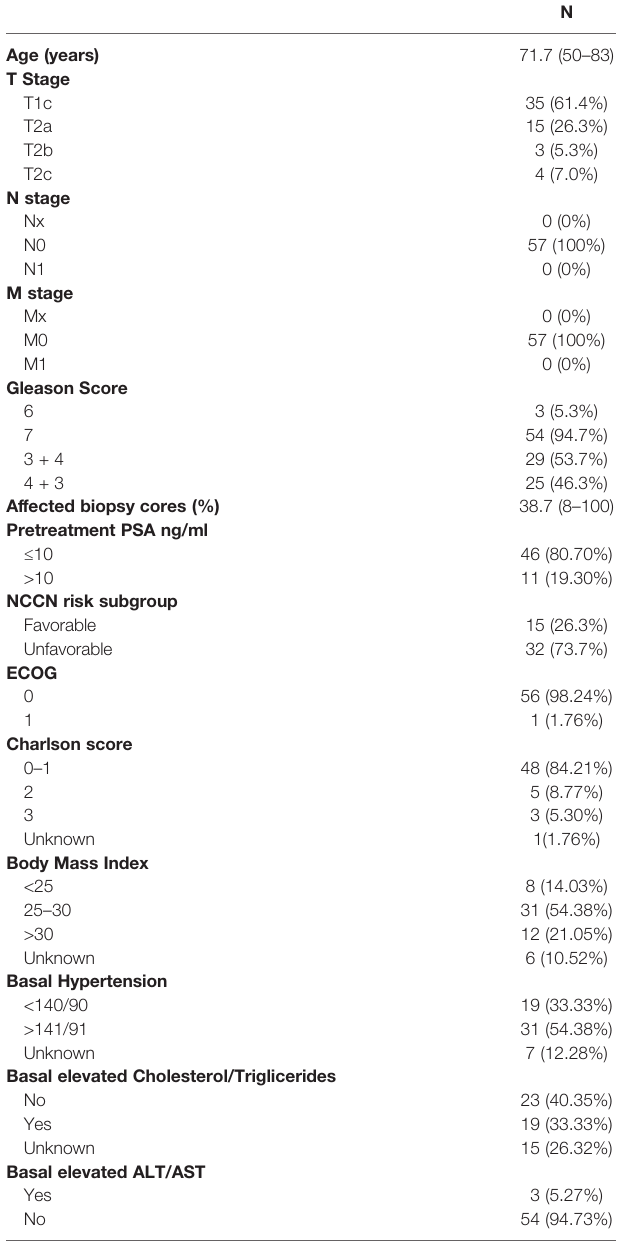
TABLE 1 | Patient Characteristics (n = 57).